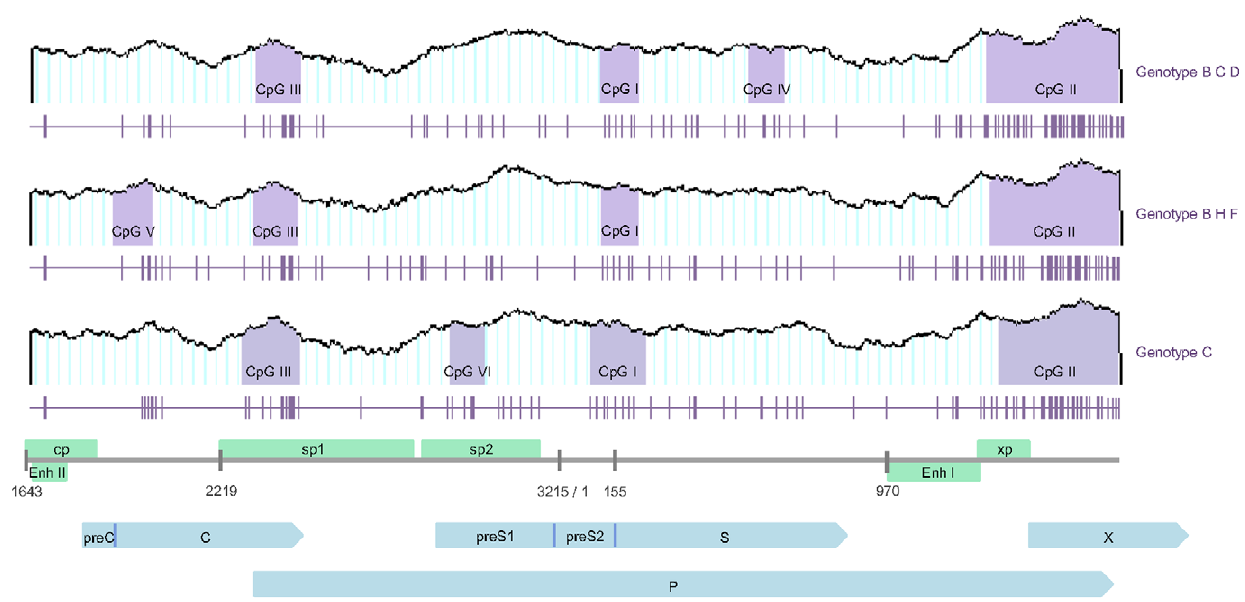
Figure 4. The three novel CpG islands identified in the HBV genome. The open reading frames of the pre-core/core, polymerase, surface antigen, and X genes are indicated as blue arrows. The four promoters, cp, sp1, sp2, and xp, and main regulatory elements, enhancers I and II (EnhI and EnhII), are indicated as green boxes. The purple areas represent CpG islands I to VI within the HBV genome. Each vertical purple line below indicates a single CpG dinucleotide. The nucleotide position is labeled according to the consensus sequence of HBV genomes with genotype C (EMBL: Y18855–Y18858).